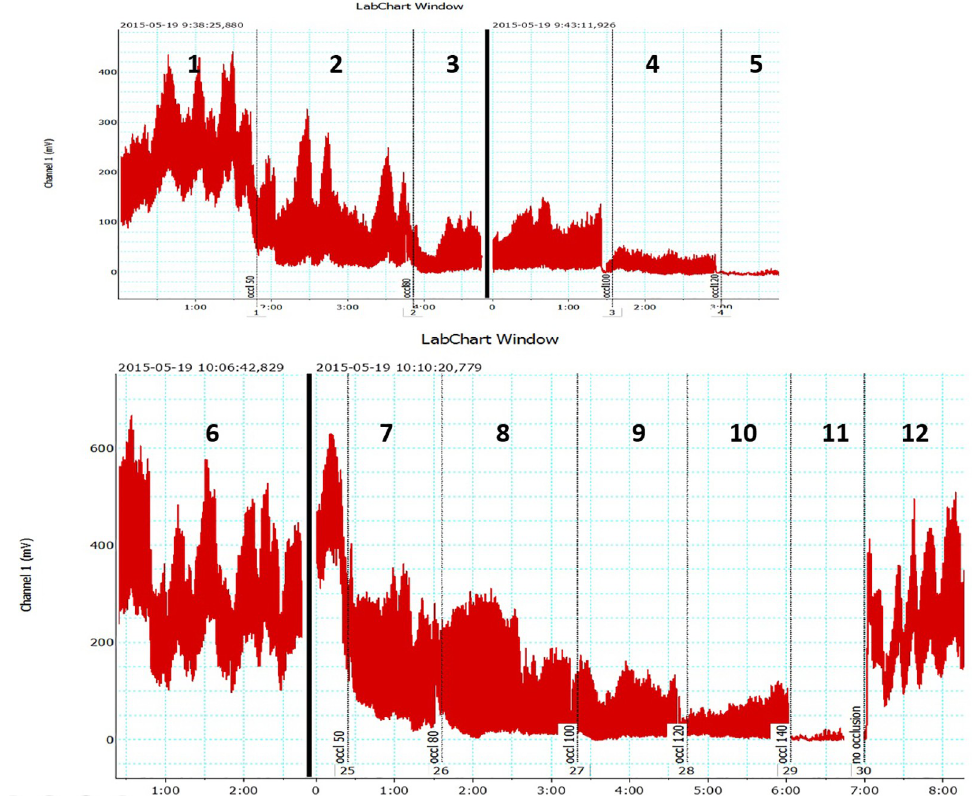
Fig 5. Laser Doppler recording of the big toe capillary flow velocity (in millivolts) before (upper part) and after (lower part) Biocompression arterial pump assist in a patient with multifocal calf arteries occlusions. Control value (point 1). In order to observe the pump effect on the capillary flow before and after pump assist the venous occlusion plethysmographic method was used at venous occlusion pressures from 50 through 80, 100, 120 and 140 mmHg, before (points 2–5) and after (points 7–11) arterial pump inflations. Comparison of the pre- and post-IPC capillary flow velocity values showed higher values after support even at the plethysmographic arterial inflow occlusion of 140 mmHg.